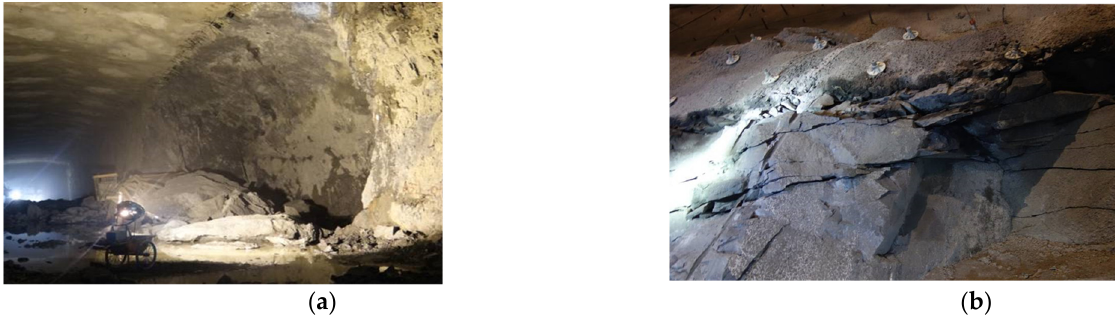
Figure 26. Rock-cracking phenomena in deep-buried caverns of Baihetan station. ( a ) Collapse of the top arch zone in powerhouse. ( b ) Cracking of the high side wall in powerhouse.